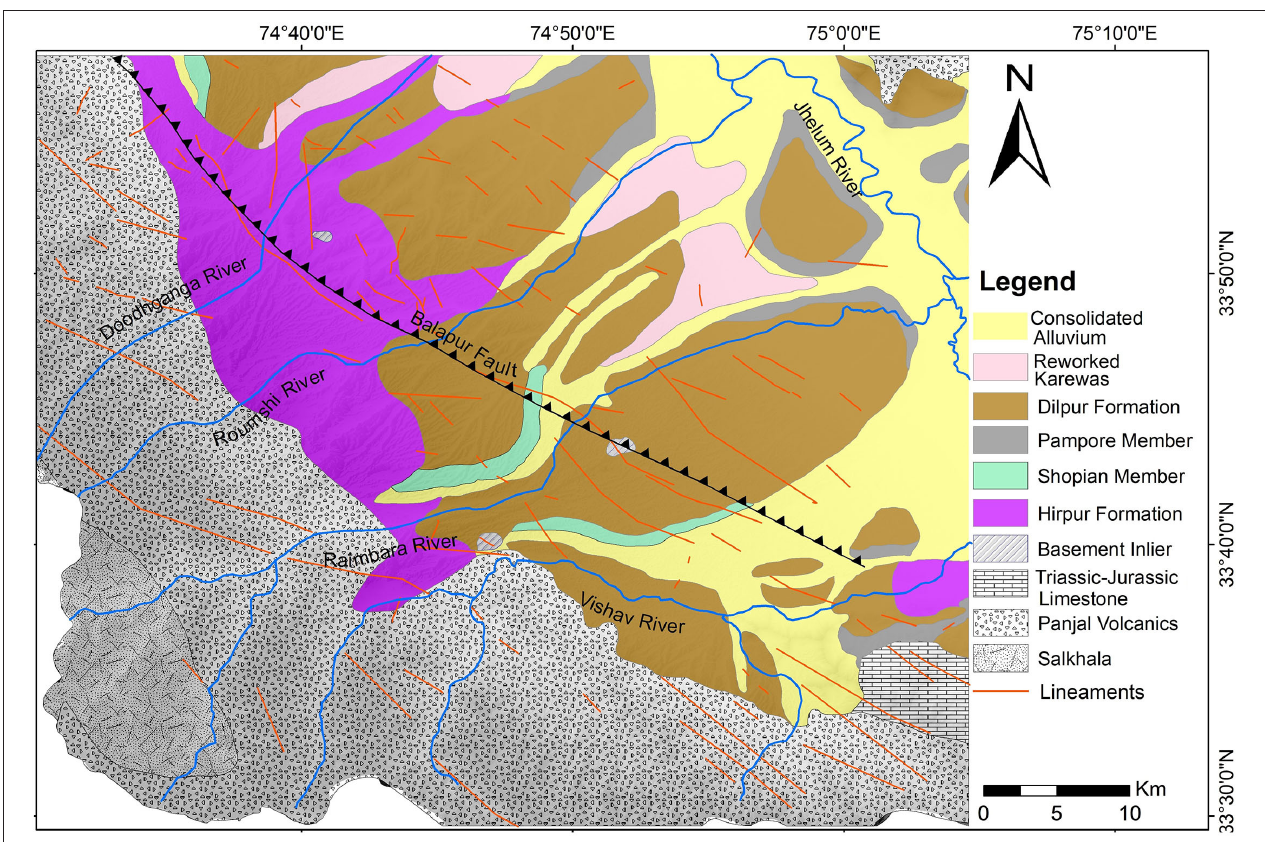
FIGURE 2 | Geological map of the Rambiara Basin and adjoining area showing Karewa deposits and major rock formations. The faults/lineaments present in and around the basin are also shown in the